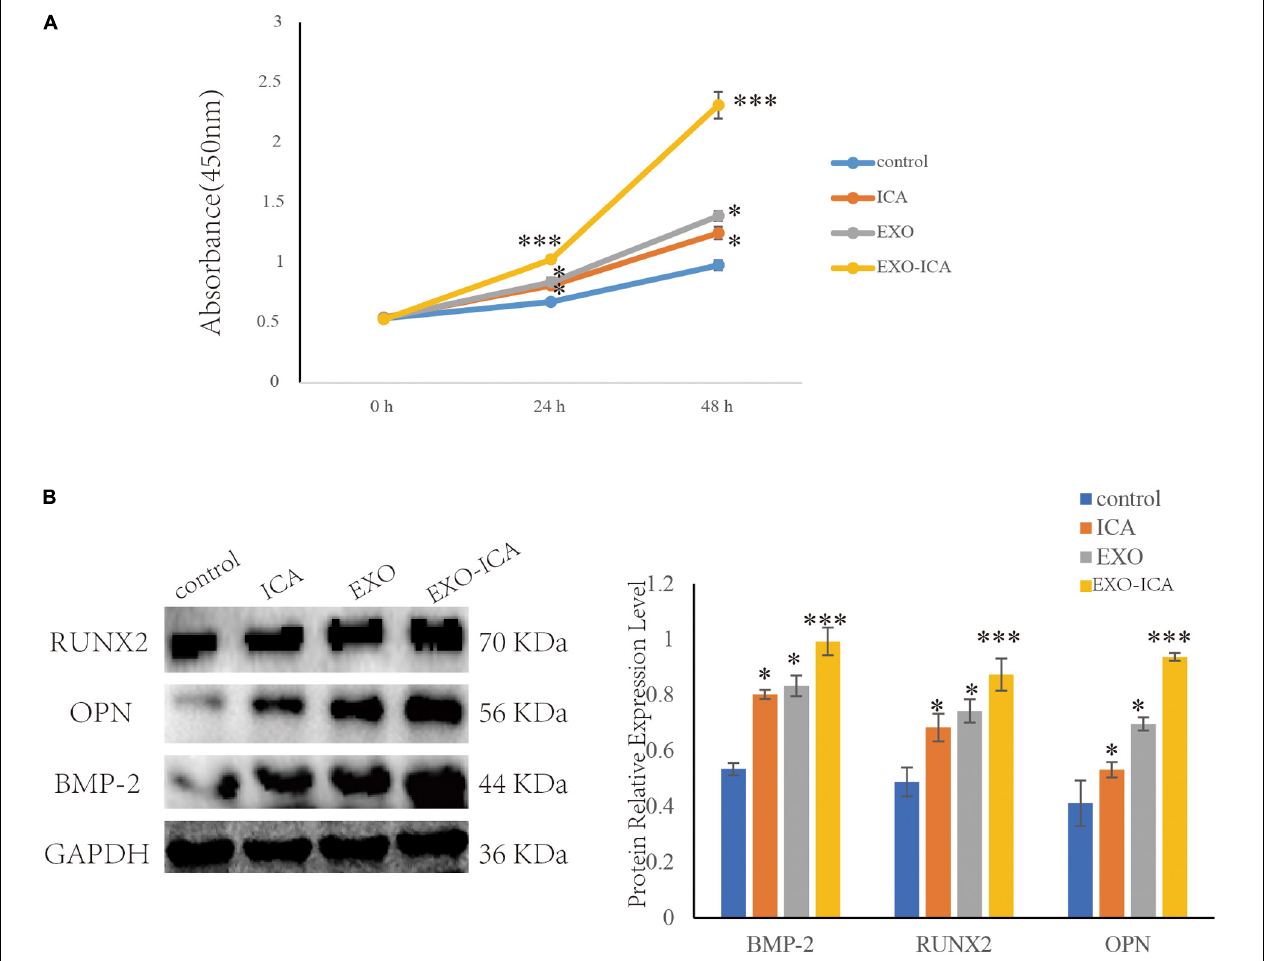
FIGURE 5 | FBS EXO-ICA promoted osteoblast proliferation. (A) CCK8 results showed that FBS EXO-ICA had a greater ability to promote the proliferation of osteoblasts than ICA; (B) Compared with ICA, FBS EXO-ICA significantly promoted the expression of the osteogenic marker proteins. * P -value < 0.05, *** P -value <